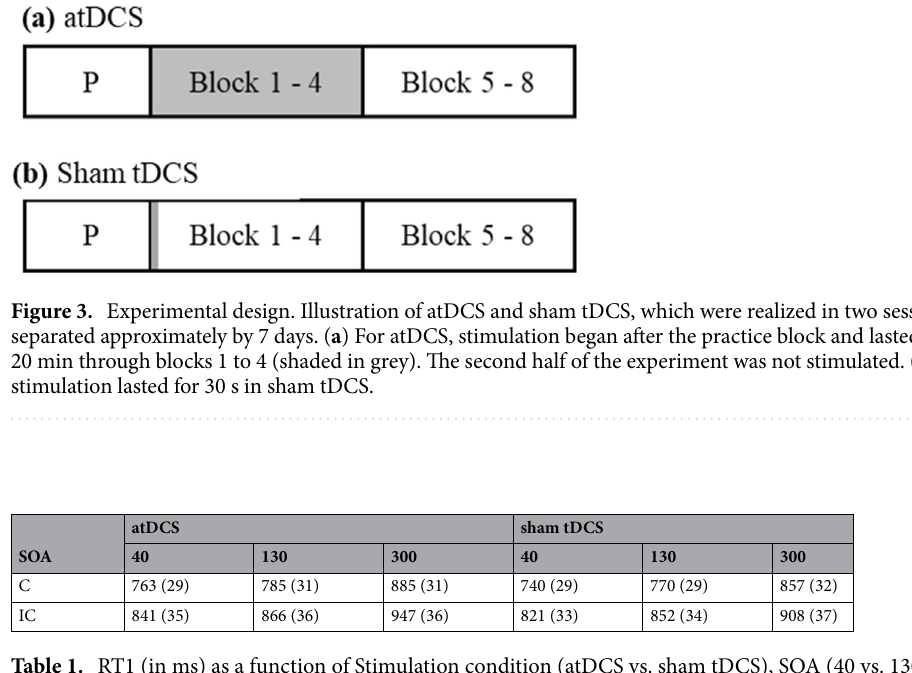
Table 1. RT1 (in ms) as a function of Stimulation condition (atDCS vs. sham tDCS), SOA (40 vs. 130 vs. 300 ms), Compatibility (compatible vs. incompatible). Standard errors of the mean are presented in parentheses.